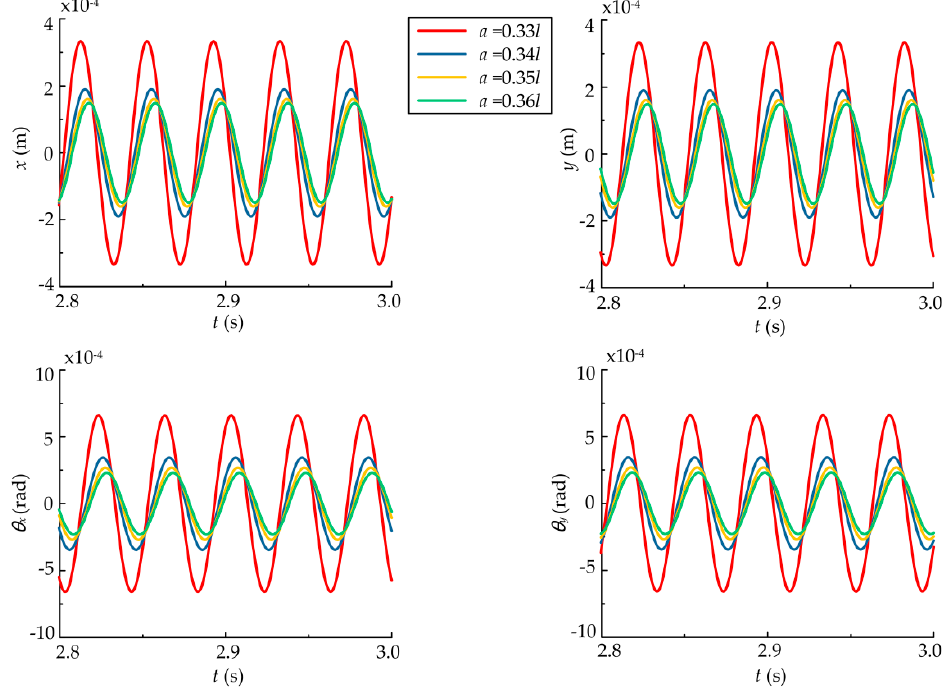
Figure 10. Time history of the dynamic responses for different rotor offsets. Appl. Sci. 2018 , 8 , 113